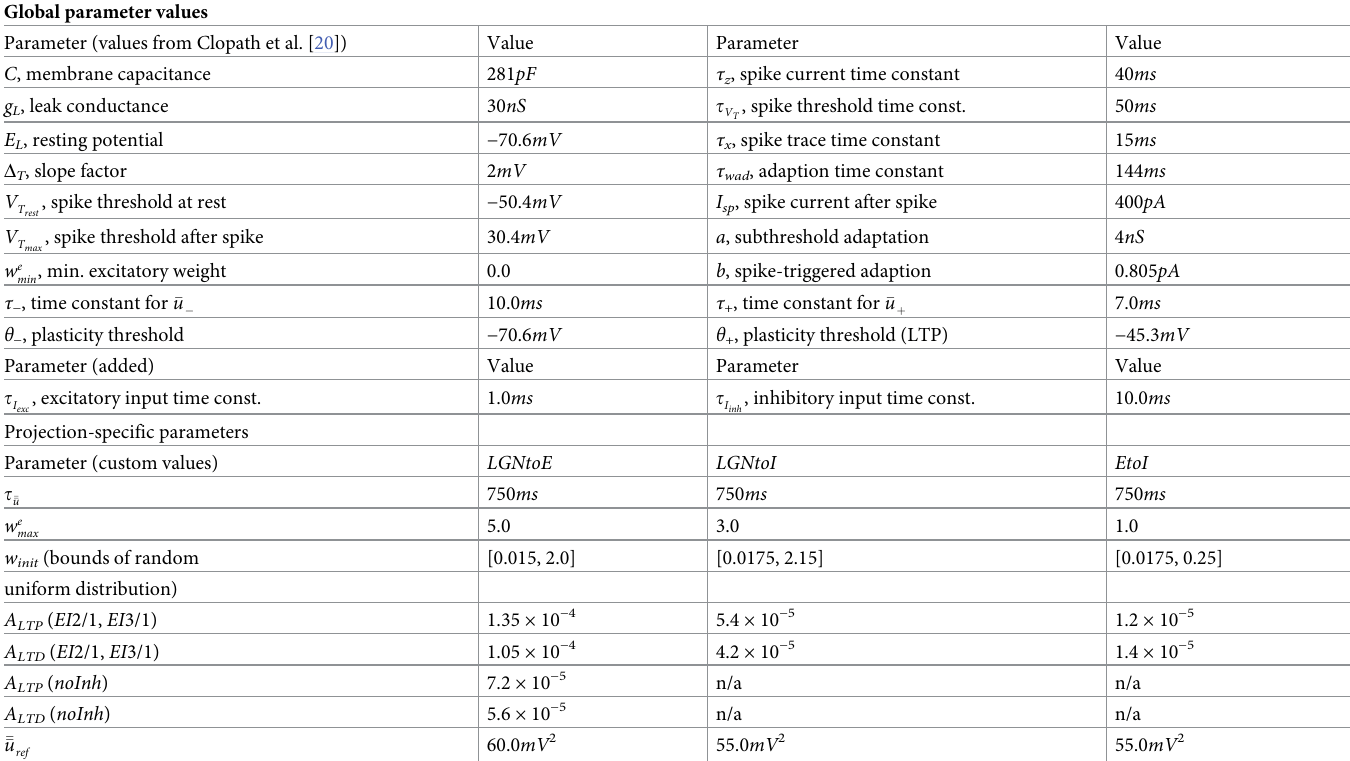
Table 1. Parameters for the neuron model and excitatory